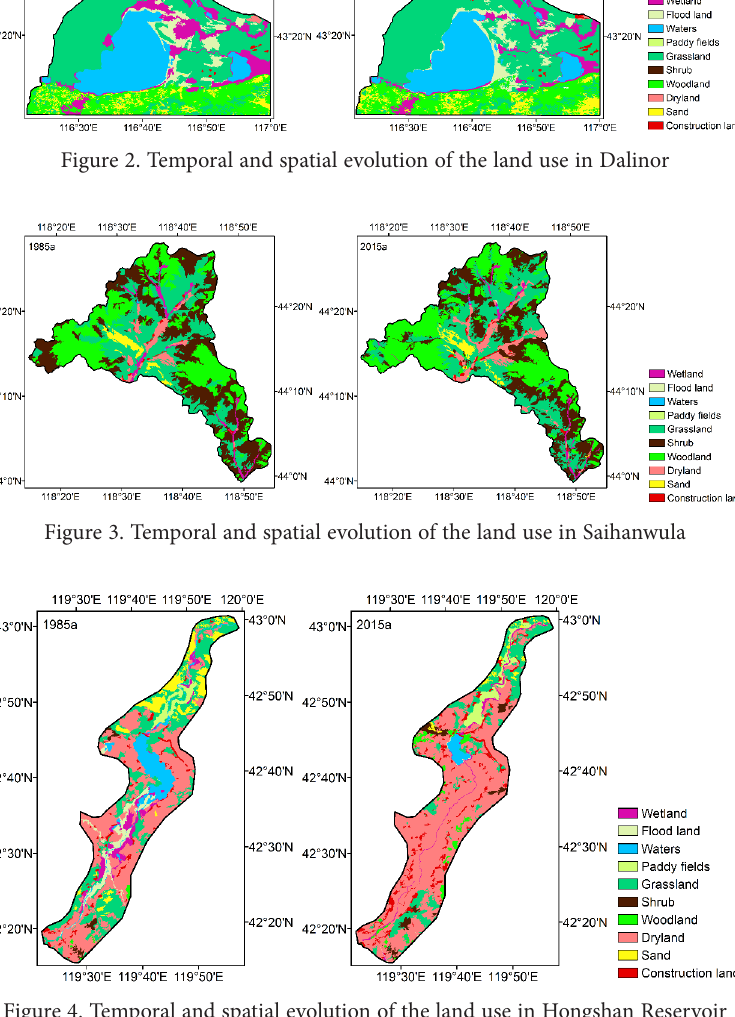
Figure 4. Temporal and spatial evolution of the land use in Hongshan